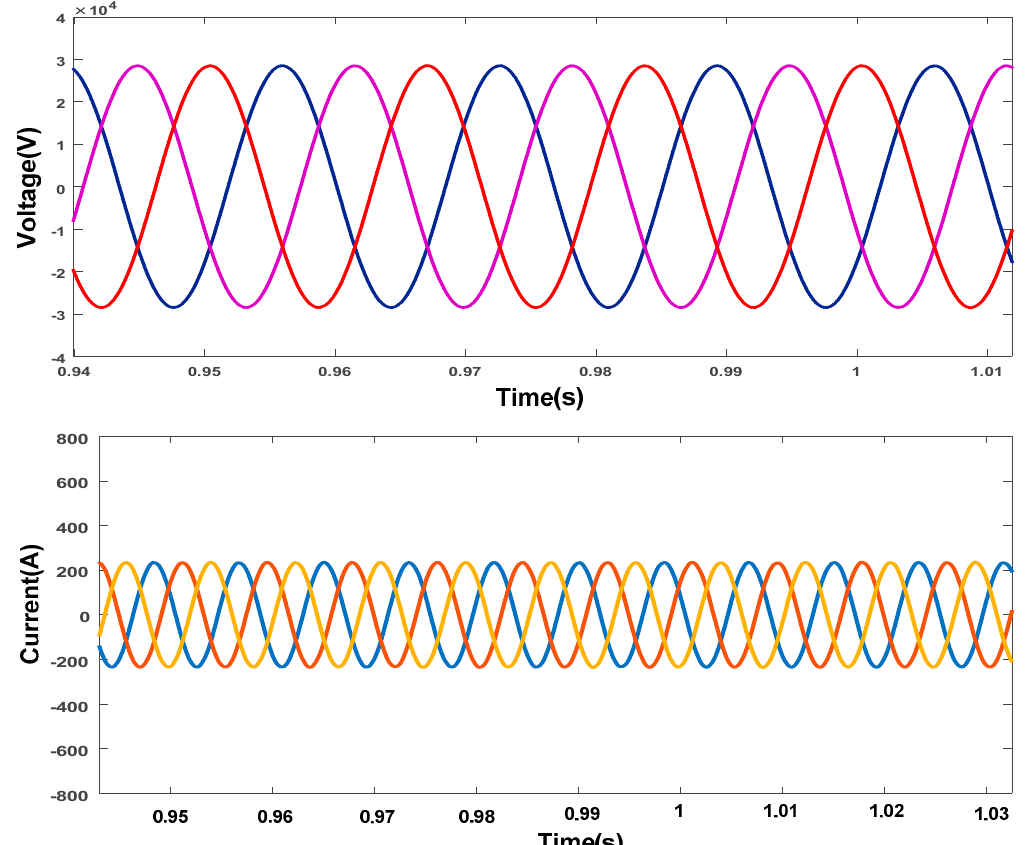
Figure 22. The magnitude voltage and current load with an imbalanced load.